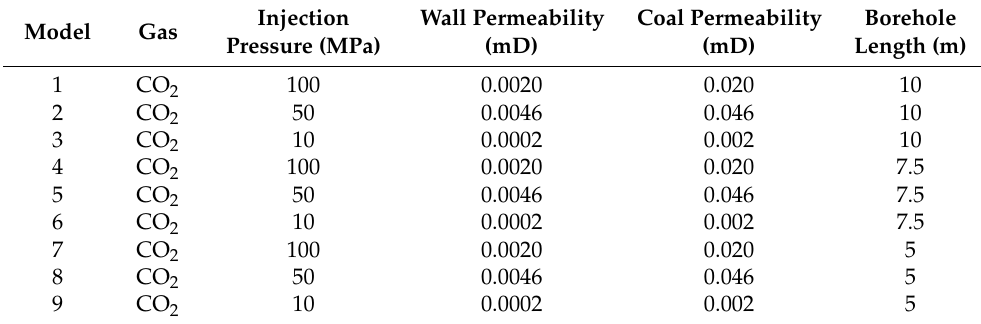
Table 4. Parameter variation in the calculated models.